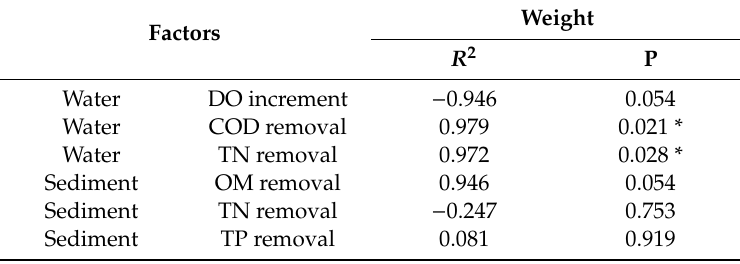
Table 3. The correlations between shrub willow ( Salix spp. ) growth and treatment e ffi ciency. Weight Factors R 2 P Water DO increment − 0.946 COD removal TN